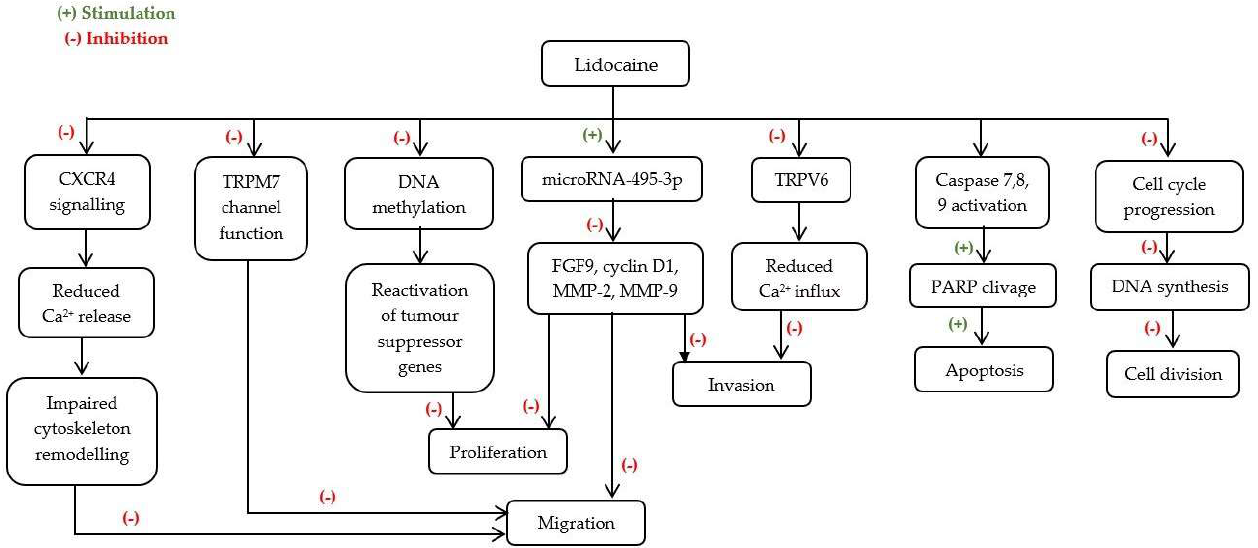
Figure 2. Possible mechanisms underlying lidocaine’s anti-cancer effects. Ca 2+ —Calcium; CXCR4— C-X-C Chemokine Receptor type 4; DNA—Deoxyribonucleic acid; FGF9—Fibroblast Growth Factor 9; MMP-2—Matrix Metallopeptidase 2; MMP-9—Matrix Metallopeptidase 9; PARP—Poly (ADP- ribose) Polymerase; TRPM7—Transient receptor potential cation channel subfamily M member 7; TRPV6—Transient receptor potential cation channel subfamily V member